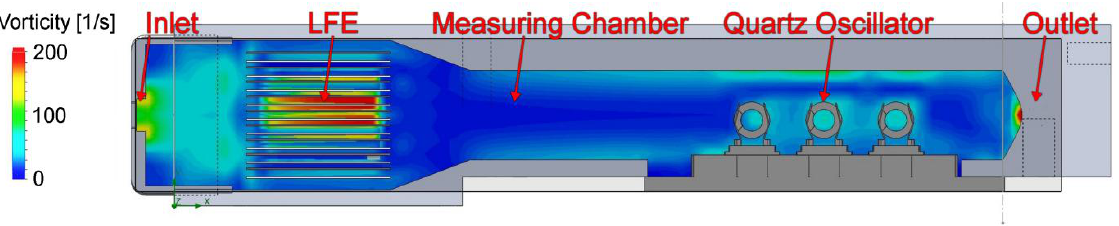
Figure 11. Vorticity of the air system in the measurement tube with laminar flow element. Inlet and outlet are defined with the same boundary conditions as in Figure 9.